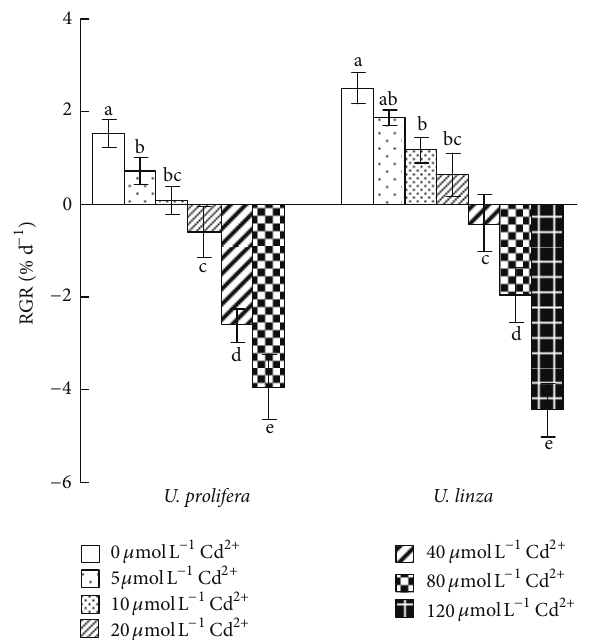
Figure 1: Effects of different concentrations of Cd 2+ (0, 5, 10, 20, 40, 80, and 120 𝜇 molL −1 ) on relative growth rate (RGR) in U. prolifera and U.